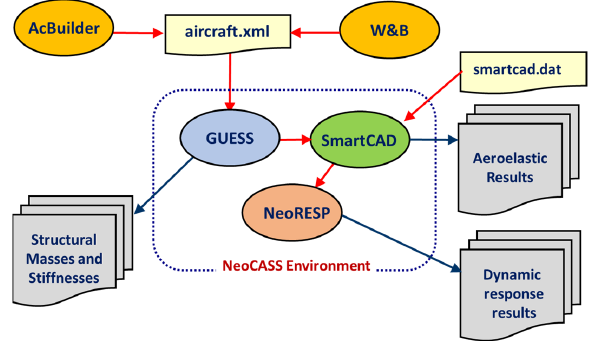
Figure 2. NeoCASS overview.